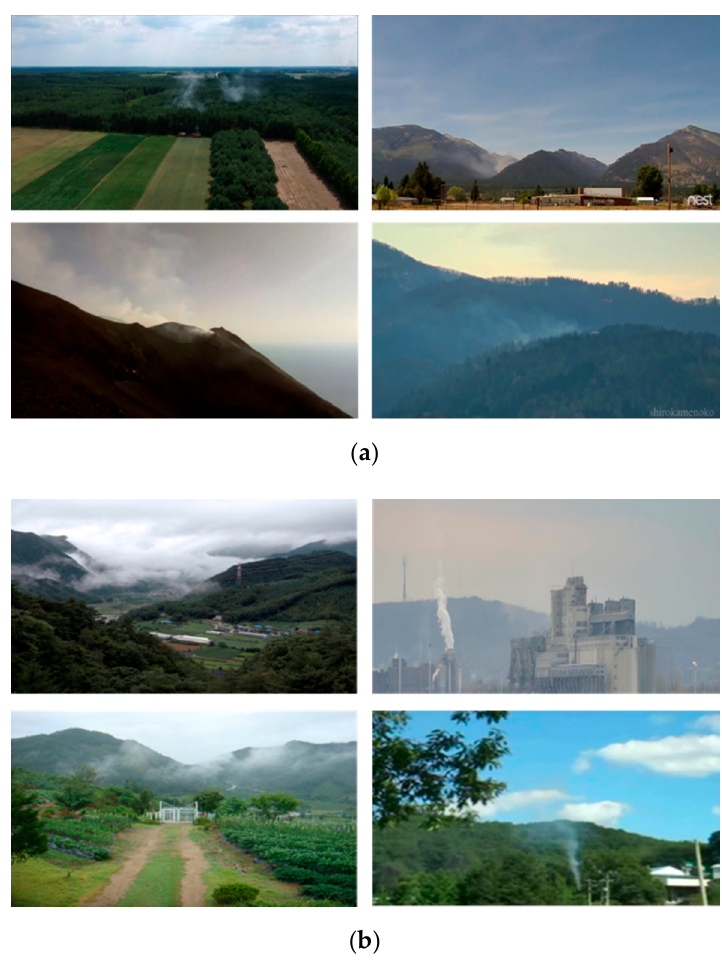
Figure 1. Examples of wildfire smoke and smoke-like cases: ( a ) An initial state of wildfire smoke captured from a camera installed on the surveillance tower of mountain and ( b ) various smoke-like cases such as clouds, fogs, and chimney smoke.